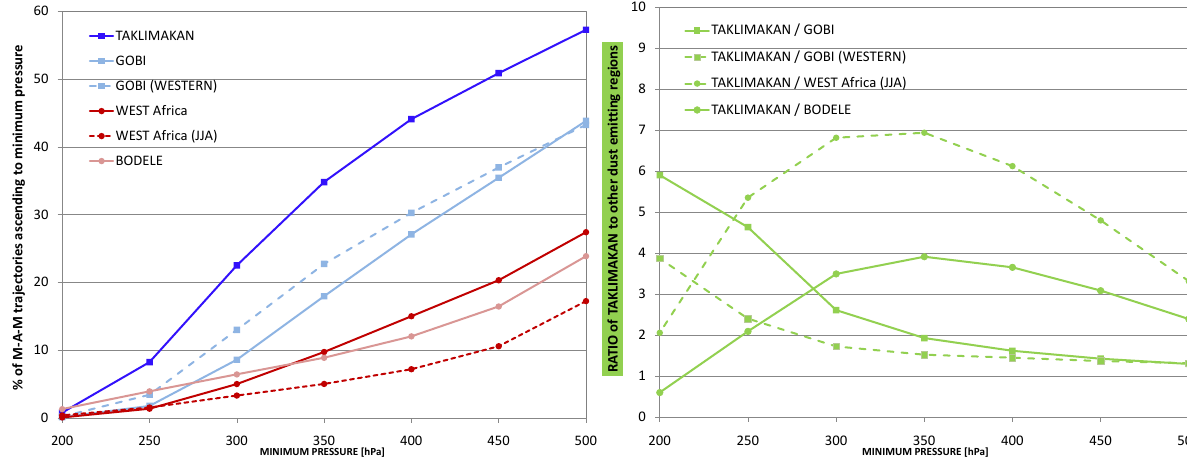
Fig. 13. Top panel shows percentage of March-April-May trajectories ascending to a given minimum pressure (hPa) from a starting pressure of 770hPa in the four geographic regions in our study, plus the western Gobi region, which is otherwise not shown in our results due to strong similarities with the eastern Gobi region. West Africa is also shown for June-July-August, when the peak of the dust emission season occurs. The bottom panel shows the ratio of ascending Taklimakan trajectories to those ascending in other dust emitting